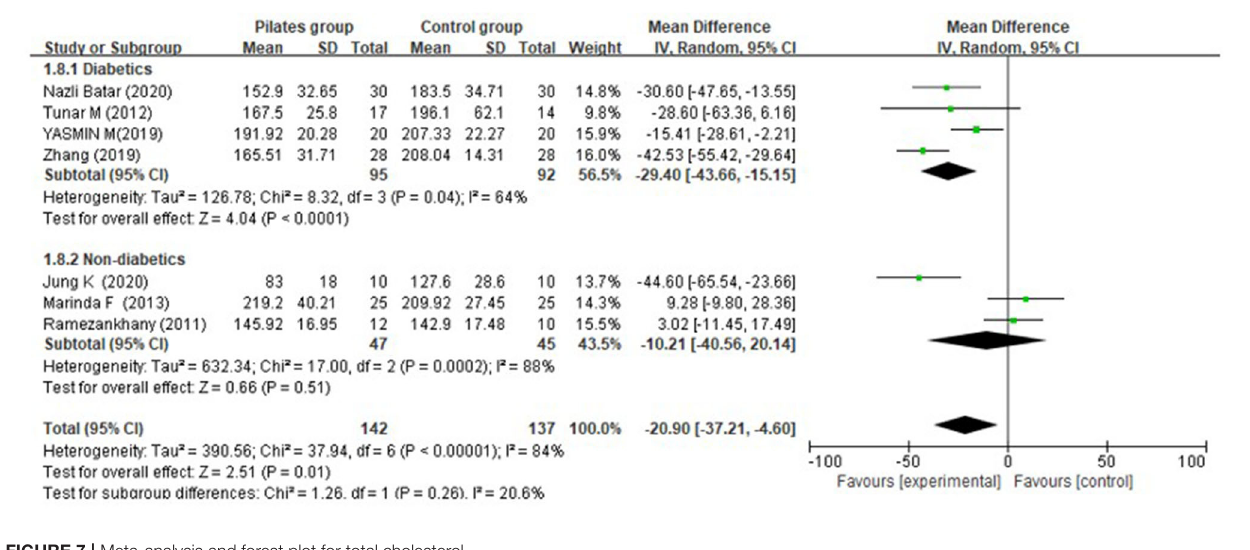
FIGURE 7 | Meta-analysis and forest plot for total cholesterol.